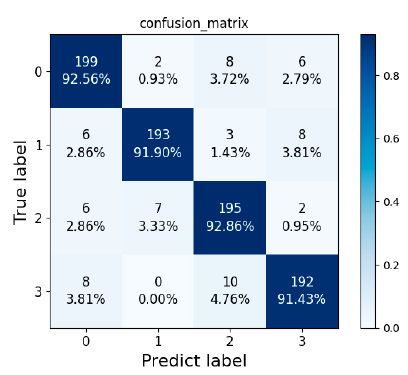
Figure 14. VGG classification model.